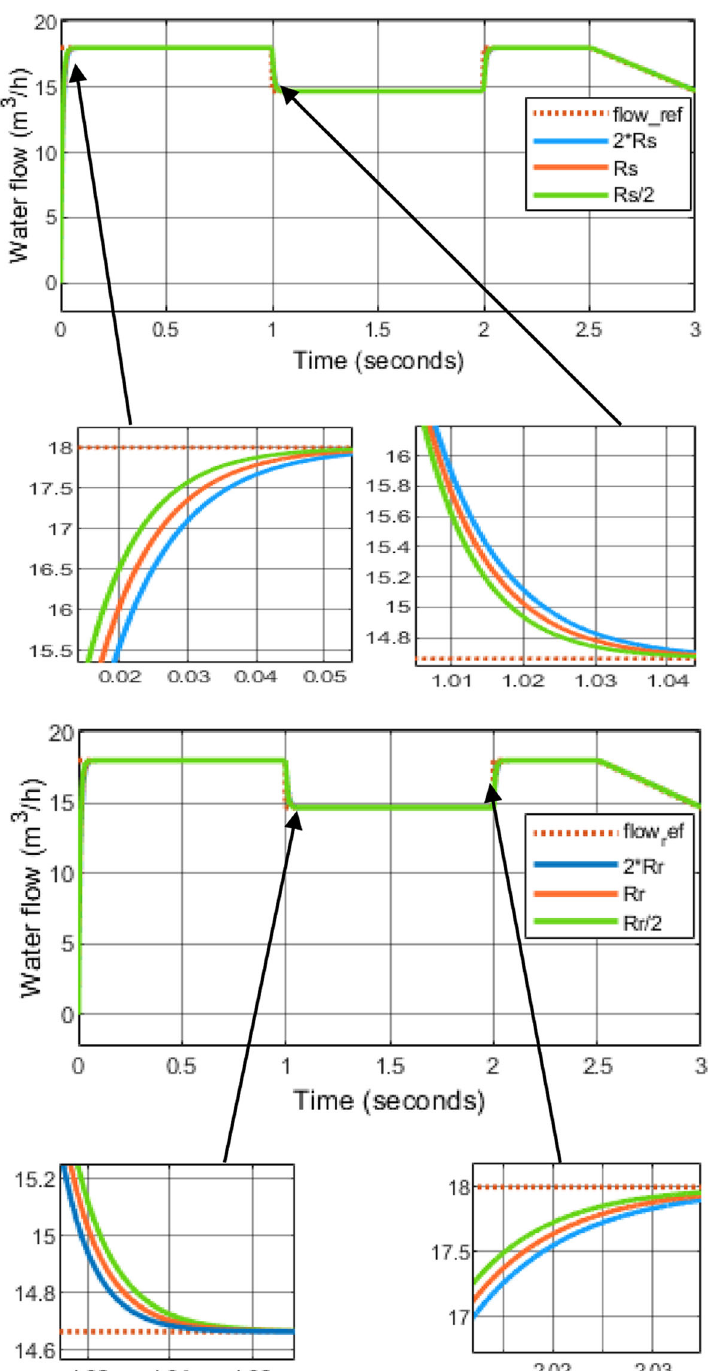
Fig. 21 Robustness test for a variation in the rotor and stator